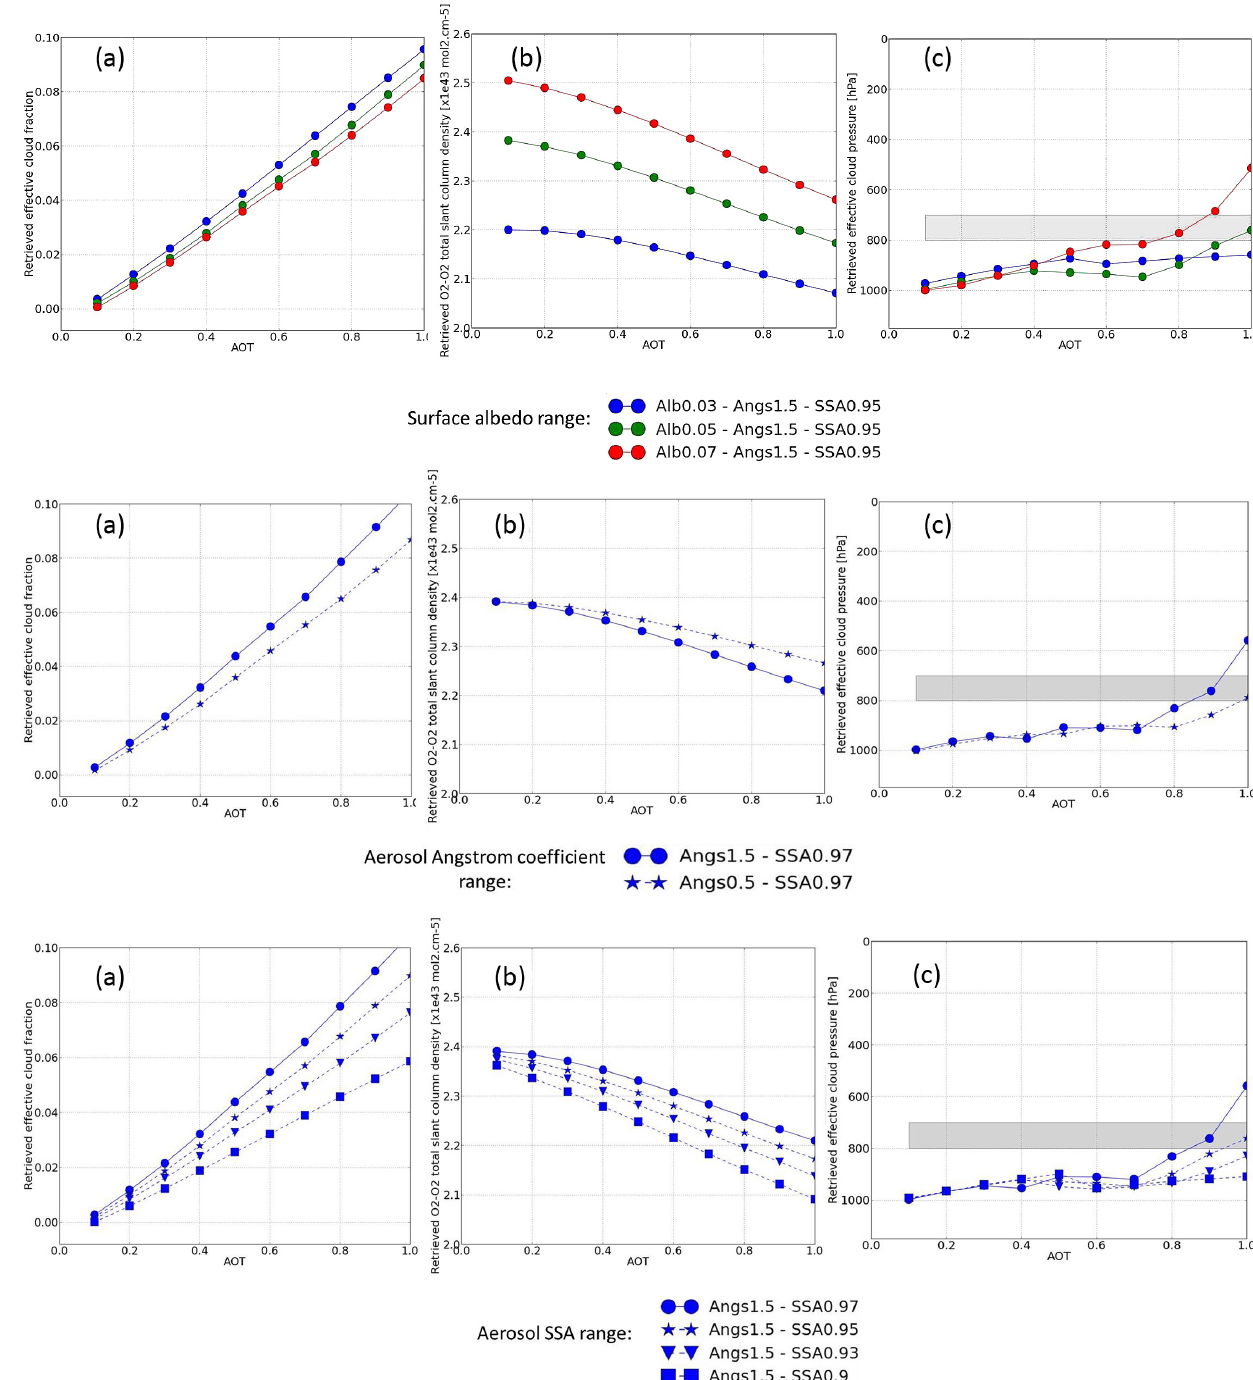
Figure 10. (a) Effective cloud, (b) O 2 − O 2 total SCD, (c) effective cloud pressure (grey colour depicts the location of the simulated aerosol layers). Top panel: Simulated DOAS O 2 − O 2 cloud retrieval results, based on noise-free spectra with aerosols, as a function of AOT and surface albedo, assuming an opaque (albedo = 0 . 8) Lambertian cloud forward model. The results are derived from the following geophysical conditions: average of temperature, H 2 O, and NO 2 vertical profiles from TM5 month July (see Fig. 1), O 2 total column = 250DU, SZA = 25 (“ ◦ ” for deg), and VZA = 25 (“ ◦ ” for deg), surface pressure = 1010hPa. Aerosol properties are SSA = 0.95, Ångström coefficient = 1.5 (fine particles), asymmetry parameter = 0.7, layers located between 700 and 800hPa. Middle panel: as top panel but the results are depicted as a function of Aerosols AOT and Ångström coefficient. The surface albedo is here constant (0.05). Bottom panel: As top panel but the results are depicted as a function of Aerosols AOT and SSA. The surface albedo is here constant